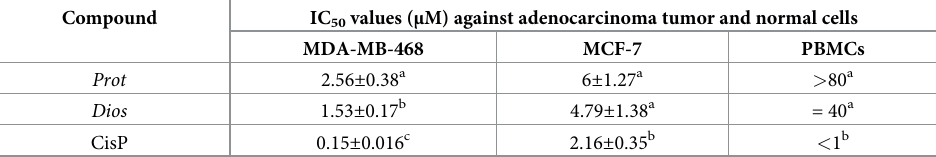
Data represented as mean ± standard deviation of three independent replicates. Different letters in the same column indicate significant differences ( p < 0.05) within conditions according to the two-way ANOVA multiple comparison range